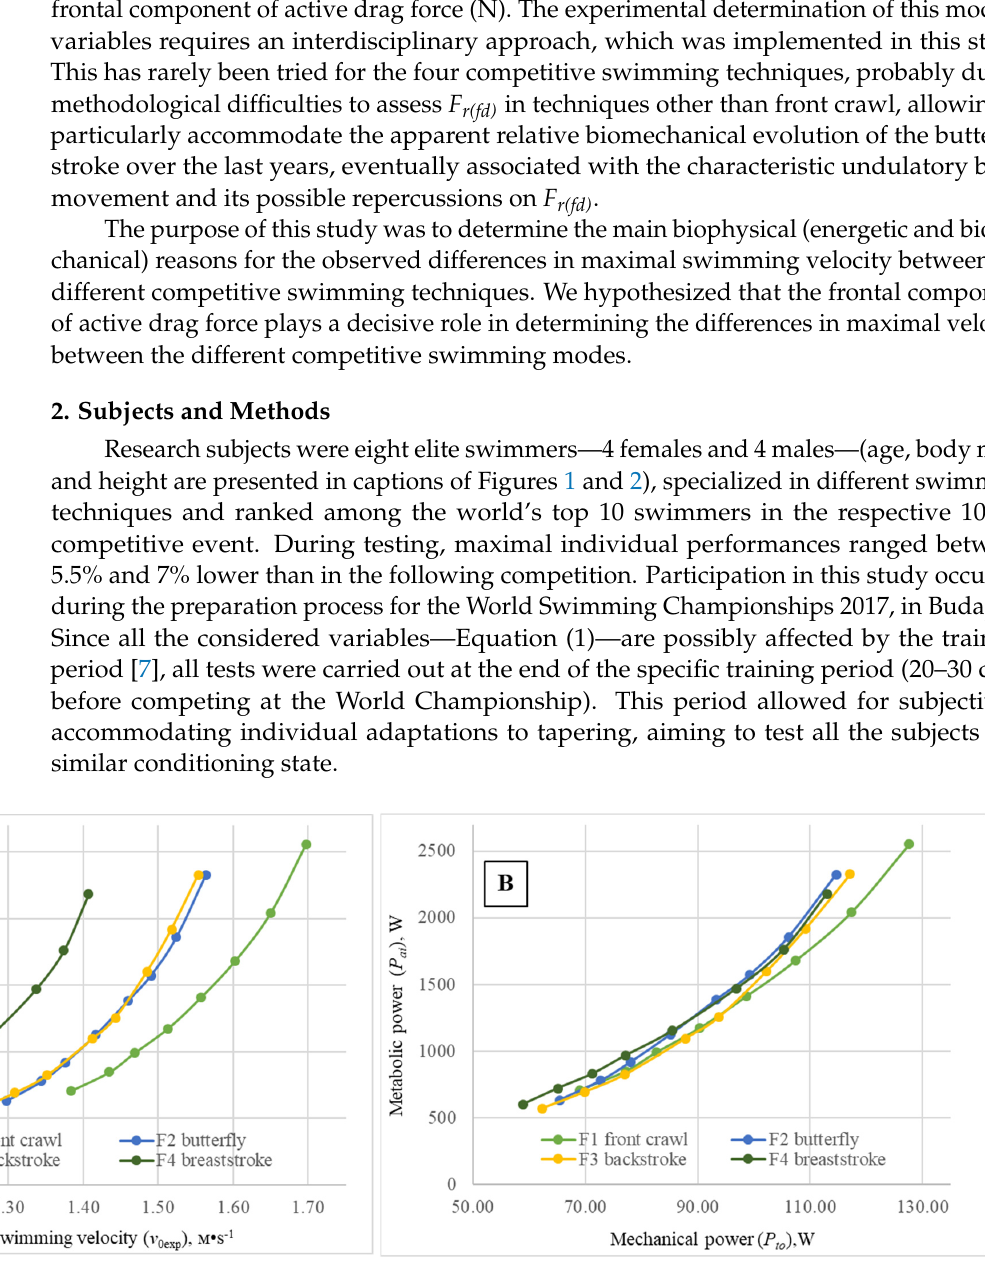
Table 1. Standard protocol of experimental records of the results in the swimming pool 8 × 100 m step-test for female subject F1 (chart A, front crawl, height—1.82 m, weight—62.6 kg, V’ O 2res —0.23 l·min − 1 ) and for male subject M3 (chart B,